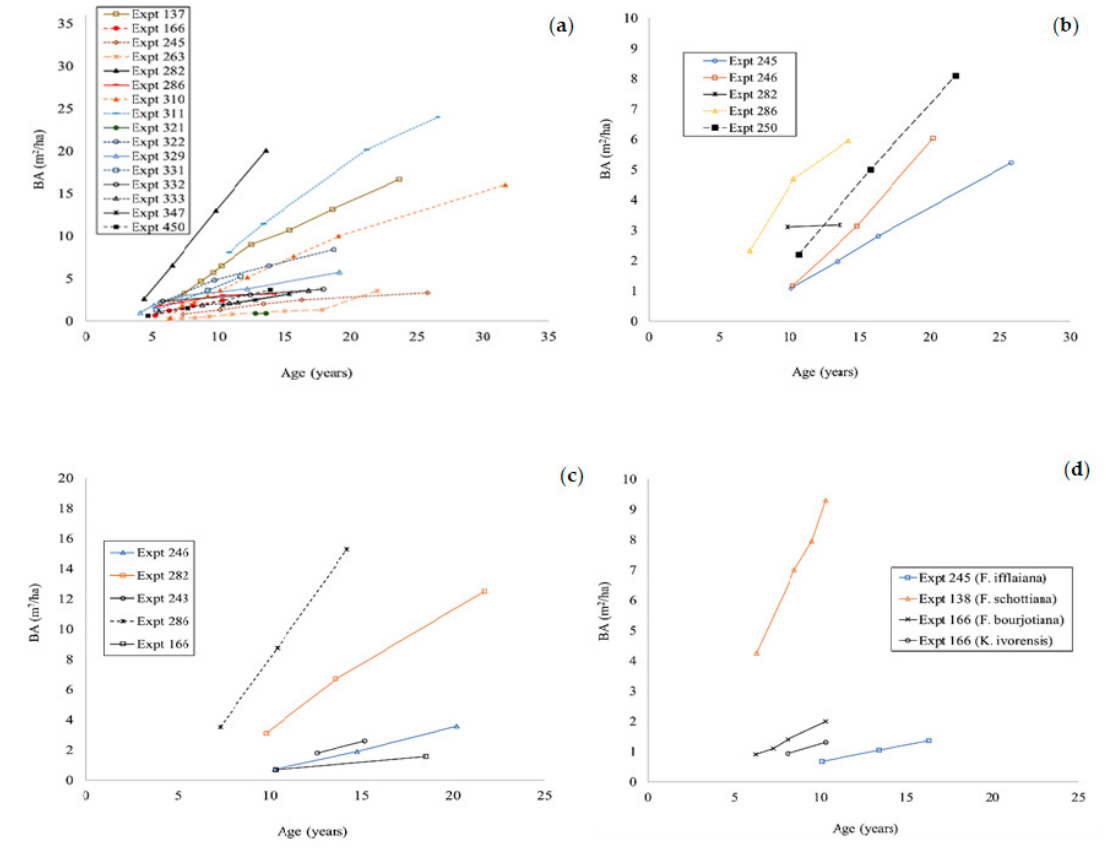
Figure 6. The growth of basal area of Flindersia brayleyana ( a ); Agathis robusta ( b ); Araucaria cunninghamii ( c ); Flindersia i ffl aiana, Flindersia schottiana, Flindersia bourjotiana, and Khaya ivorensis ( d ) in enrichment planting experiments in north